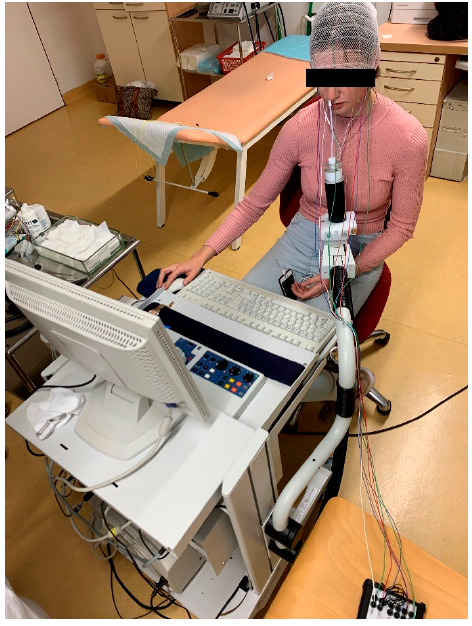
Figure 8. Objective olfactometry (from co-author’s archive).